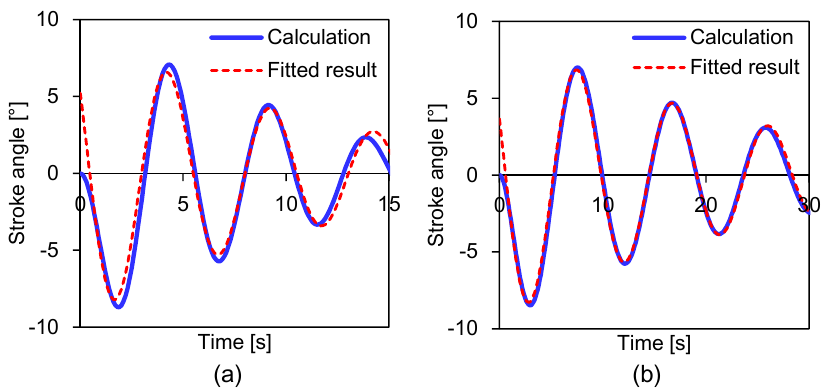
Figure 9. Resonant frequency estimation by impulse response: ( a ) small type and ( b ) large type.